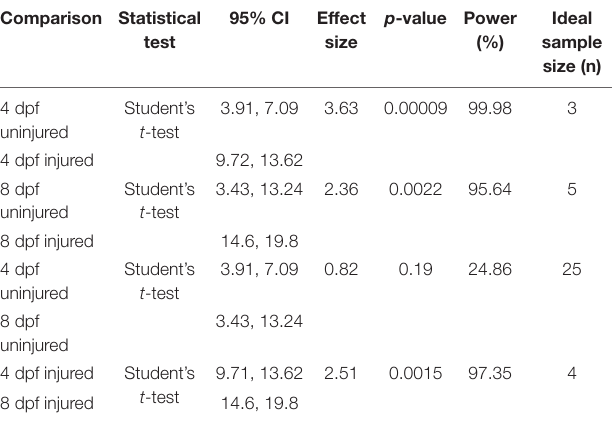
TABLE 3 | Calculation of statistical power for comparing the number of muSCs in 4 and 8 dpf zebrafish larvae after muscle